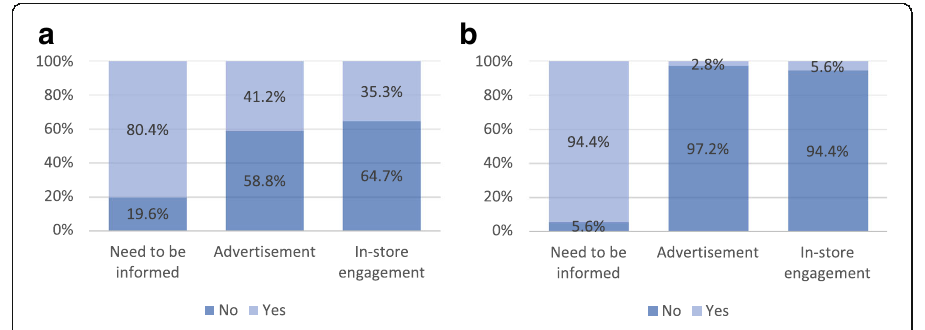
Fig. 12 a the percentage of surveyed Danish managers ’ opinions regarding customers ’ reaction to the DR activities in stores. N = 51 . b the percentage of surveyed Philippines managers ’ opinions regarding customers ’ reaction to the DR activities in stores. N = 36